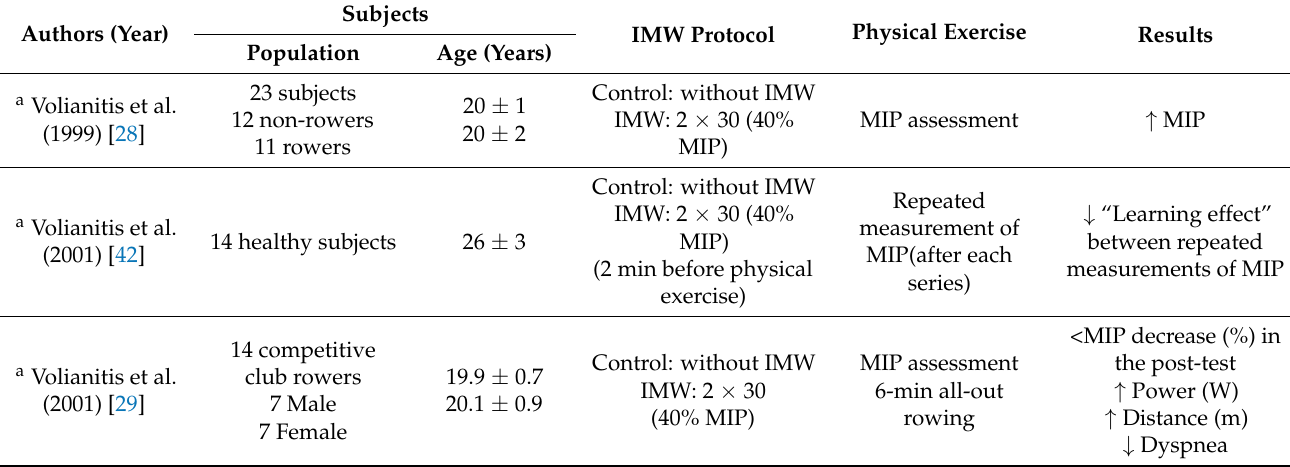
Table 3. Description of the IMW protocols. a POWERbreathe ® . b PowerLung ® . c Flow-restriction device. d Not informed.